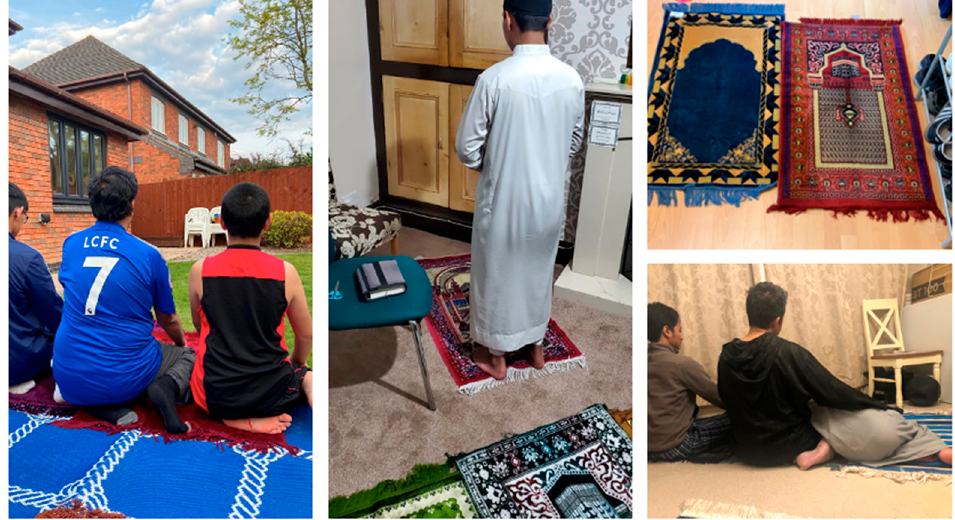
Figure 7. Compilation of images sent by various participants showing or symbolising congregational family prayers.